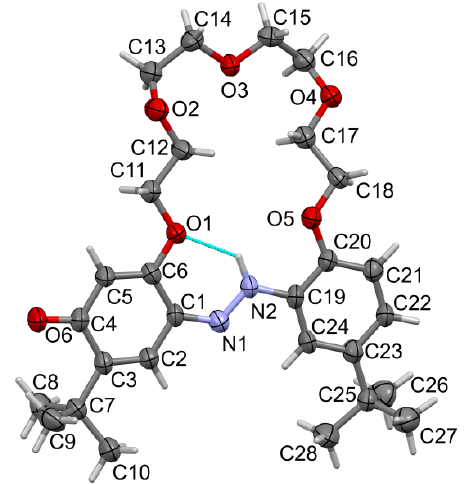
Figure 5. Molecular view of t -Bu-19- p -OH showing atom labelling scheme in one molecule, arbitrarily selected from the two symmetry-independent molecules in the structure. Intramolecular hydrogen bonding is drawn as the dashed cyan line. Displacement ellipsoids are drawn at a 50% probability level. Selected bond lengths (Å) and angles (°): N1-N2 1.315(6), N1-C1 1.325(7), N2-C19